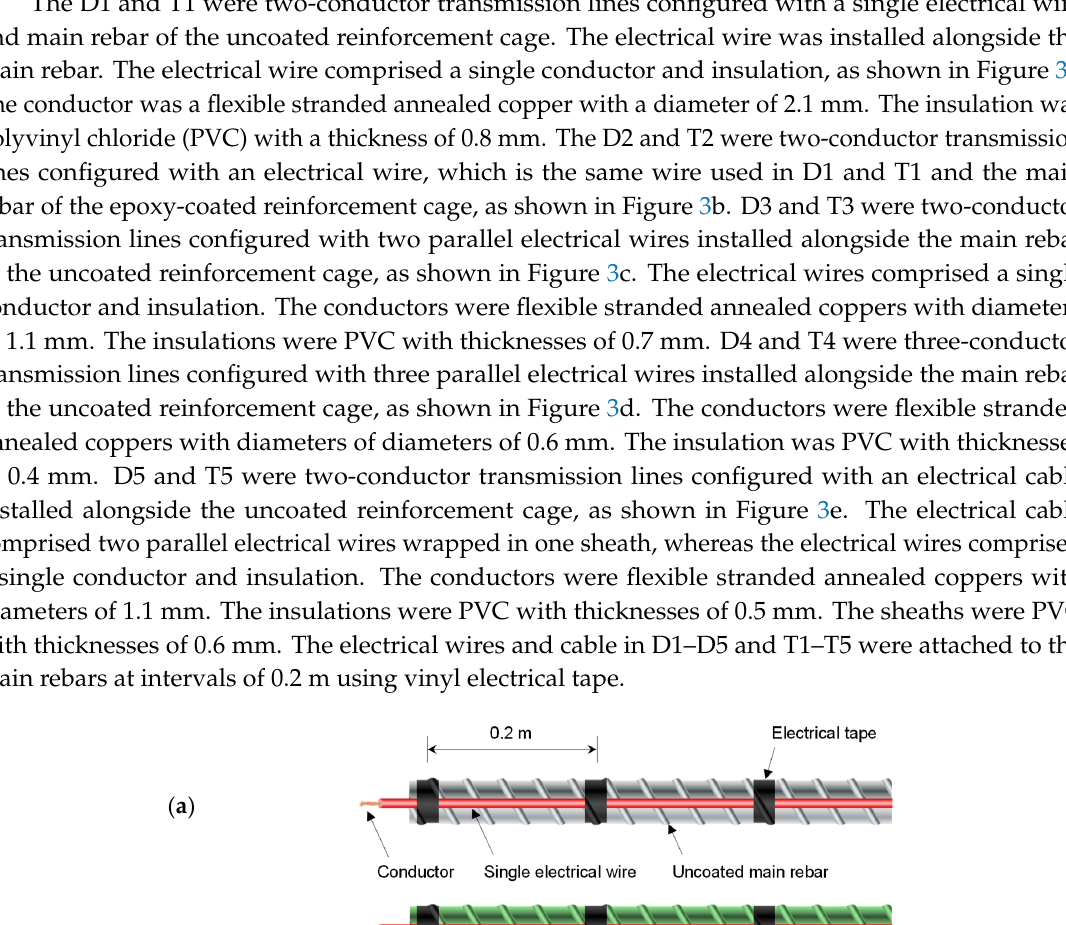
Figure 2. Uncoated reinforcement cage ( left ) and epoxy-coated reinforcement cage ( right ).